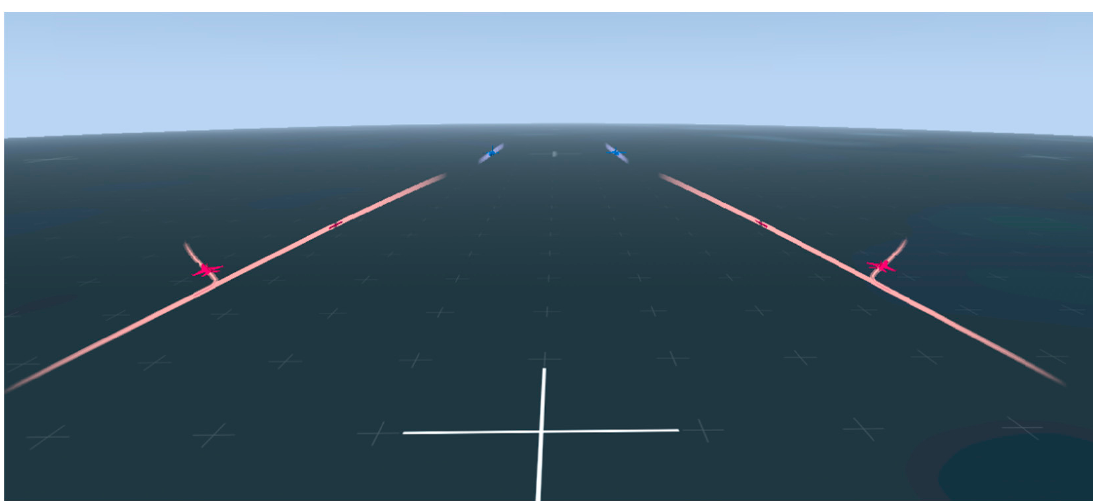
Figure 7. The two-on-two BVR air combat.